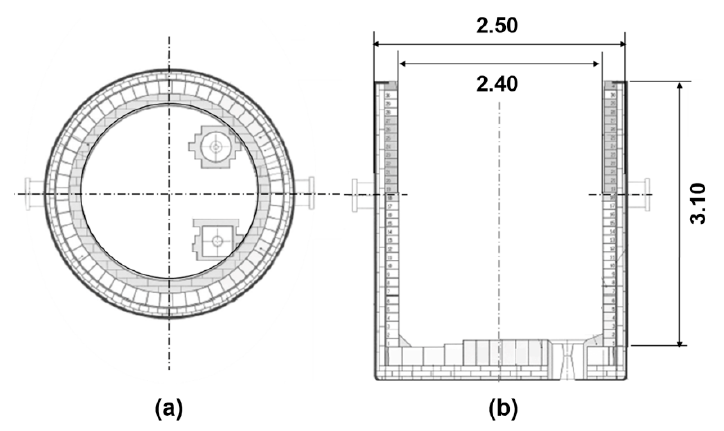
Figure 1. Geometry of the ladle furnace (m). ( a ) Top view, ( b ) Frontal view.